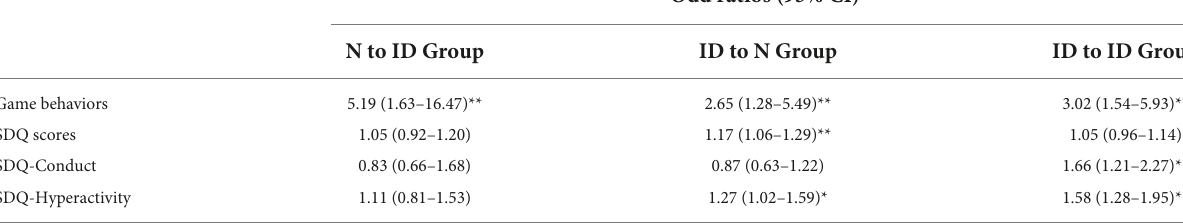
TABLE 3 Estimates from the multivariate multinomial logistics regression model of the Internet addiction changing